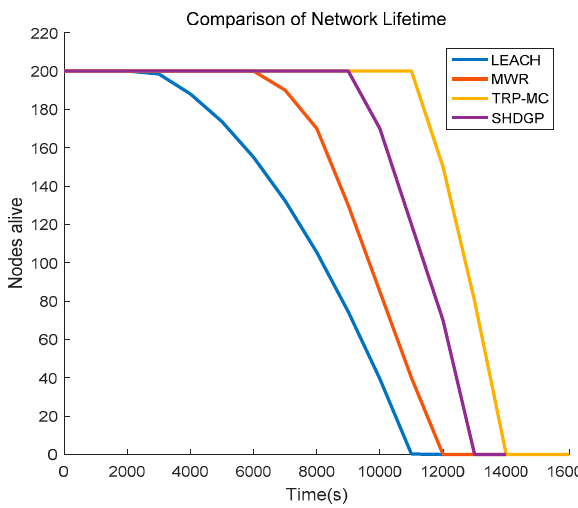
Figure 11. Comparison of network lifetime between different algorithms.